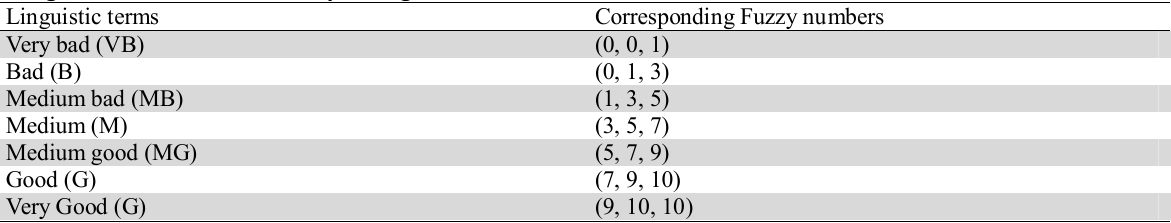
Corresponding Fuzzy numbers Linguistic